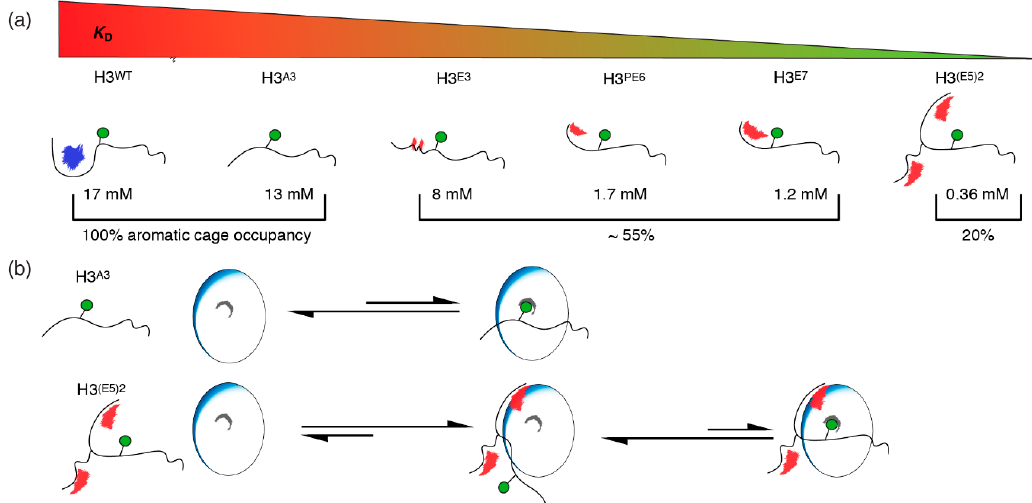
Figure 6. Possible binding mechanism for the studied peptide models and their respective binding affinities. ( a ) A schematic illustration of the peptide models used in this study. A continuous manipulation of the peptide sequence towards the incorporation of increasing negative charges results in a consistent boost of binding affinity (H3 A3 < H3 E3 < H3 PE6 < H3 E7 ). This can be further optimized by introducing structural motifs that resemble the electrostatic surrounding of the H3 tail in a nucleosomal context (H3 (E5)2 ). However, a decrease in the fraction of occupied aromatic cage suggests that the improved binding is due to electrostatic interactions. ( b ) Possible binding mechanism, explaining the observed effects for mutant peptide binding. H3 WT and H3 A3 engage in a PSIP1 PWWP binding that does not include favorable electrostatic interactions and has Kme3 complexation as sole driving force. In case of Glu-rich peptides and especially H3 (E5)2 , the peptide engages in an encounter complex facilitated by electrostatic interactions. Of this complex, only a fraction of Kme3 (20%) is additionally complexed by the aromatic cage (reaction rates indicated with arrow length).